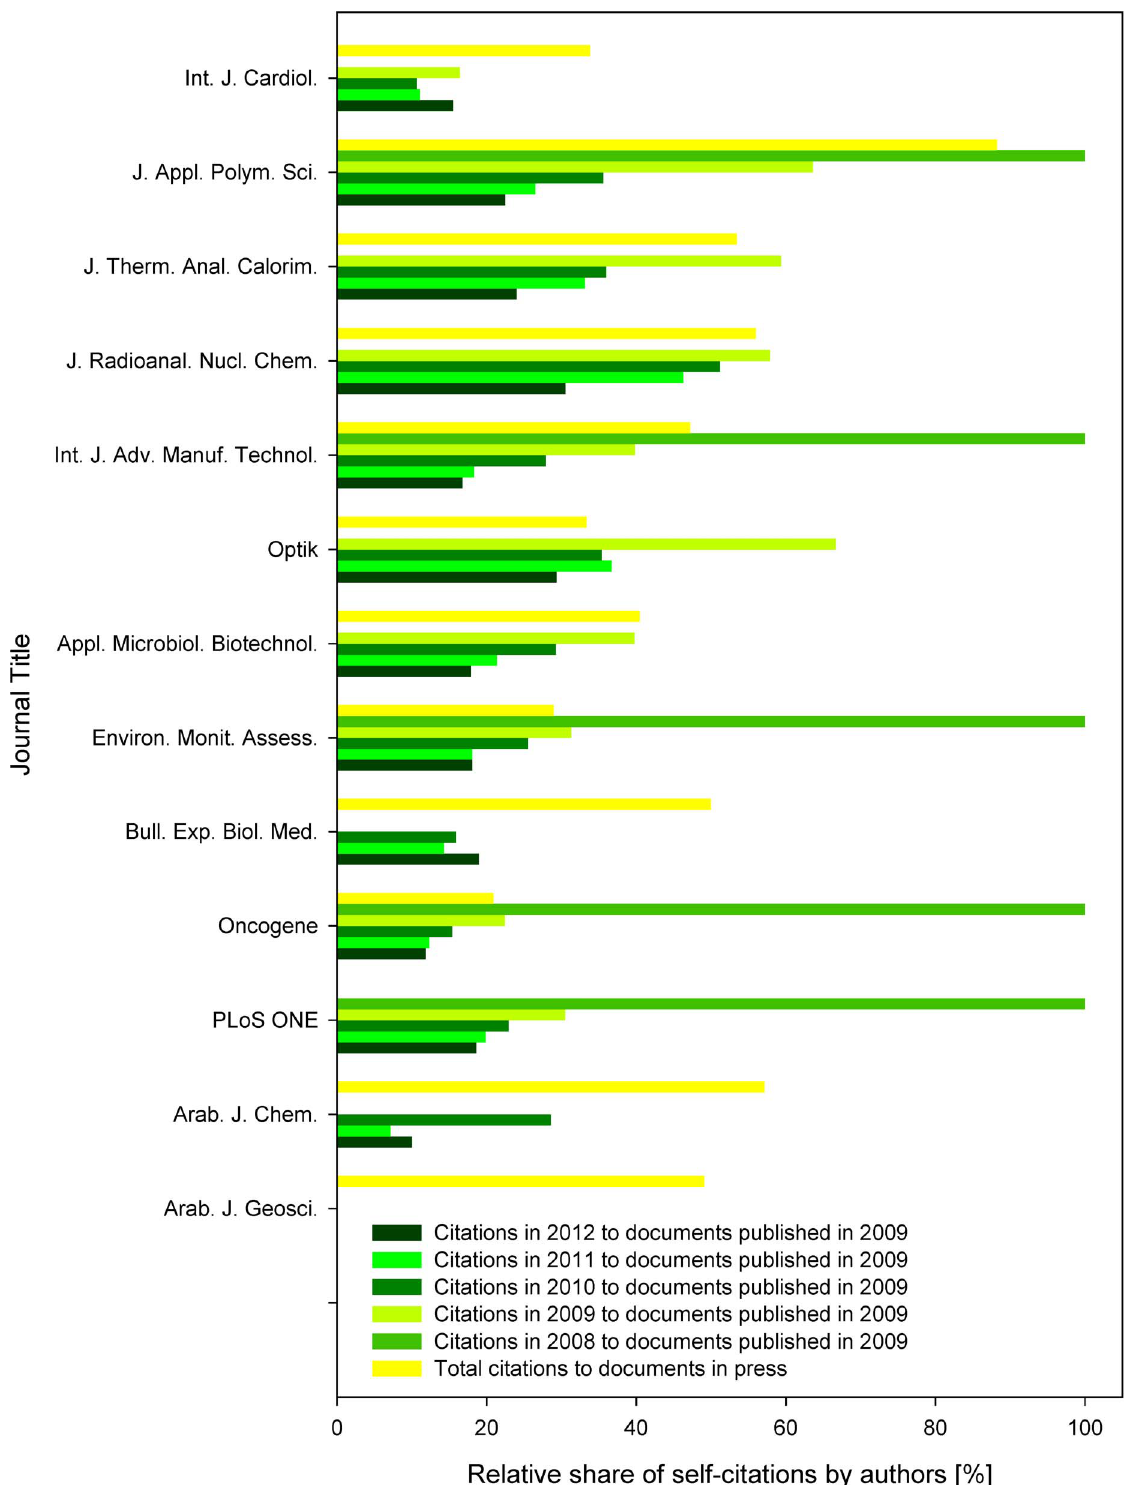
Figure 4. Relative share of authors’ self-citations. The data represent shares of citations, when at least one of the authors of a cited document was the same person as one of the authors of the citing document. Indicated are relative shares of authors’ self-citations among total citations to documents in press, and (annually) among citations in 2008–2012 to documents published in 2009. Except for Int. J. Cardiol . cites in 2008 to 2009, all the other zero values indicate absence of the source data in Scopus.